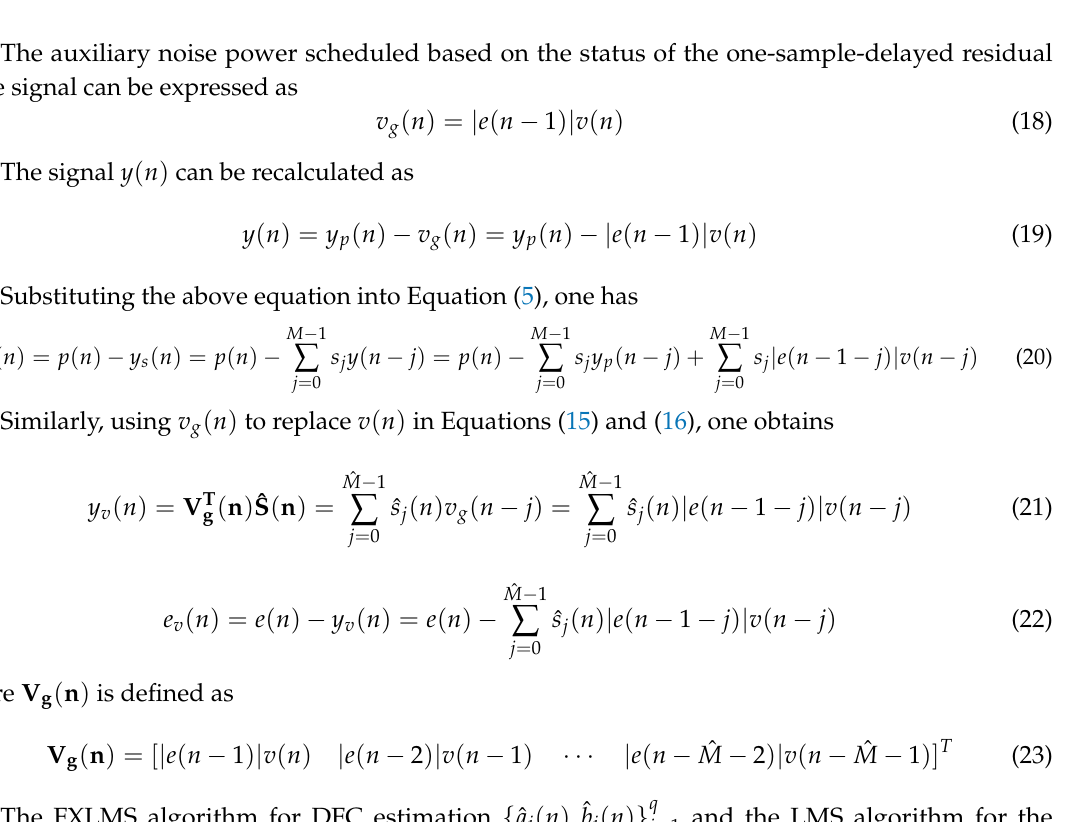
Figure 2. NANC system with online SPM using scaled auxiliary noise injection ( i th